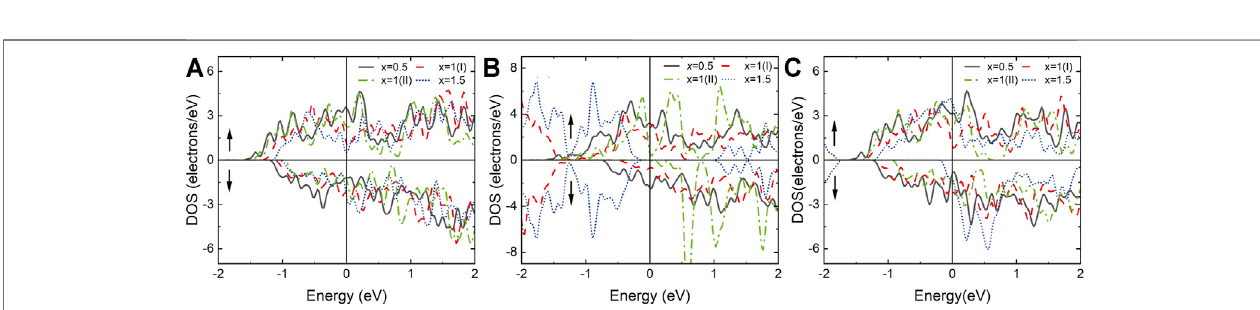
FIGURE 8 | Total density of state(DOS) of (A) Nd 2 N(OH) x , (B) Nd 2 NO x , and (C) Nd 2 NF x , where x = 0.5, 1(I), 1(II), and 1.5.